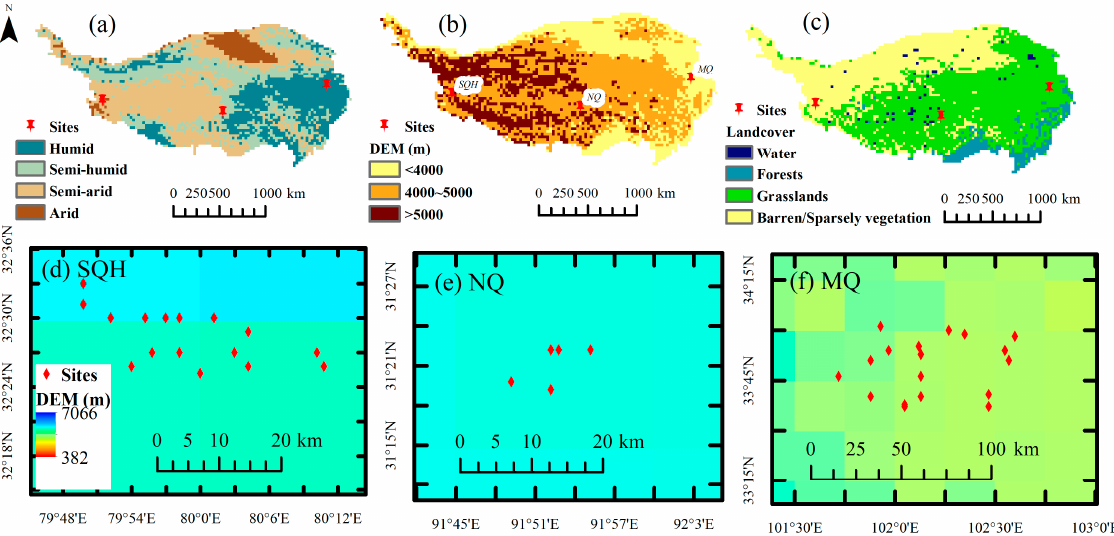
Figure 1. Zonation by climate ( a ), elevation ( b ), and land cover type ( c ), and the soil moisture (SM) observation networks in the SQH ( d ), NQ ( e ), and MQ ( f ) areas on the Qinghai-Tibet Plateau (QTP), composed of SM sites marked in red diamonds. The locations of the networks are shown in ( b ).